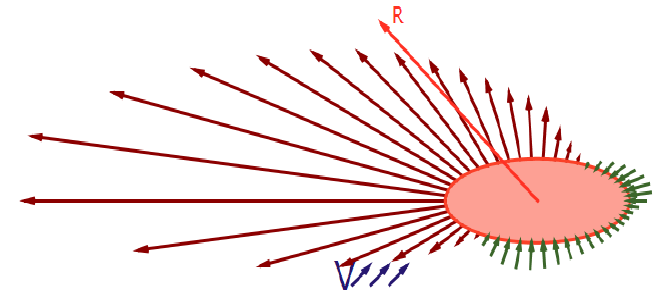
Fig. 11. Distribution of the pressure coefficient on the profile surface during the circulation flow around an elliptical